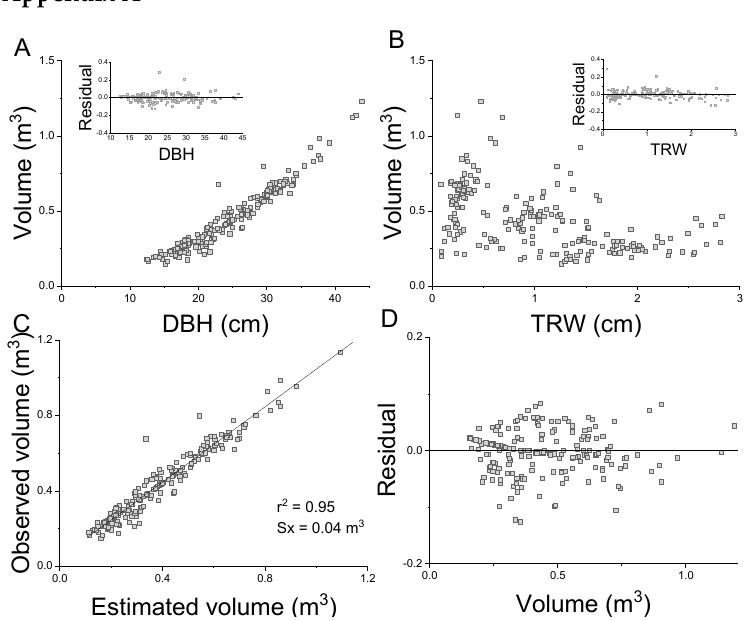
Figure A1. Volume of P. patula at different age and independent variables DBH ( A ) and RW ( B ) of fitted Equation (1) and their residuals, analyze included both stands. Regression between the observed and estimated volume ( C ) and their residual ( D ).